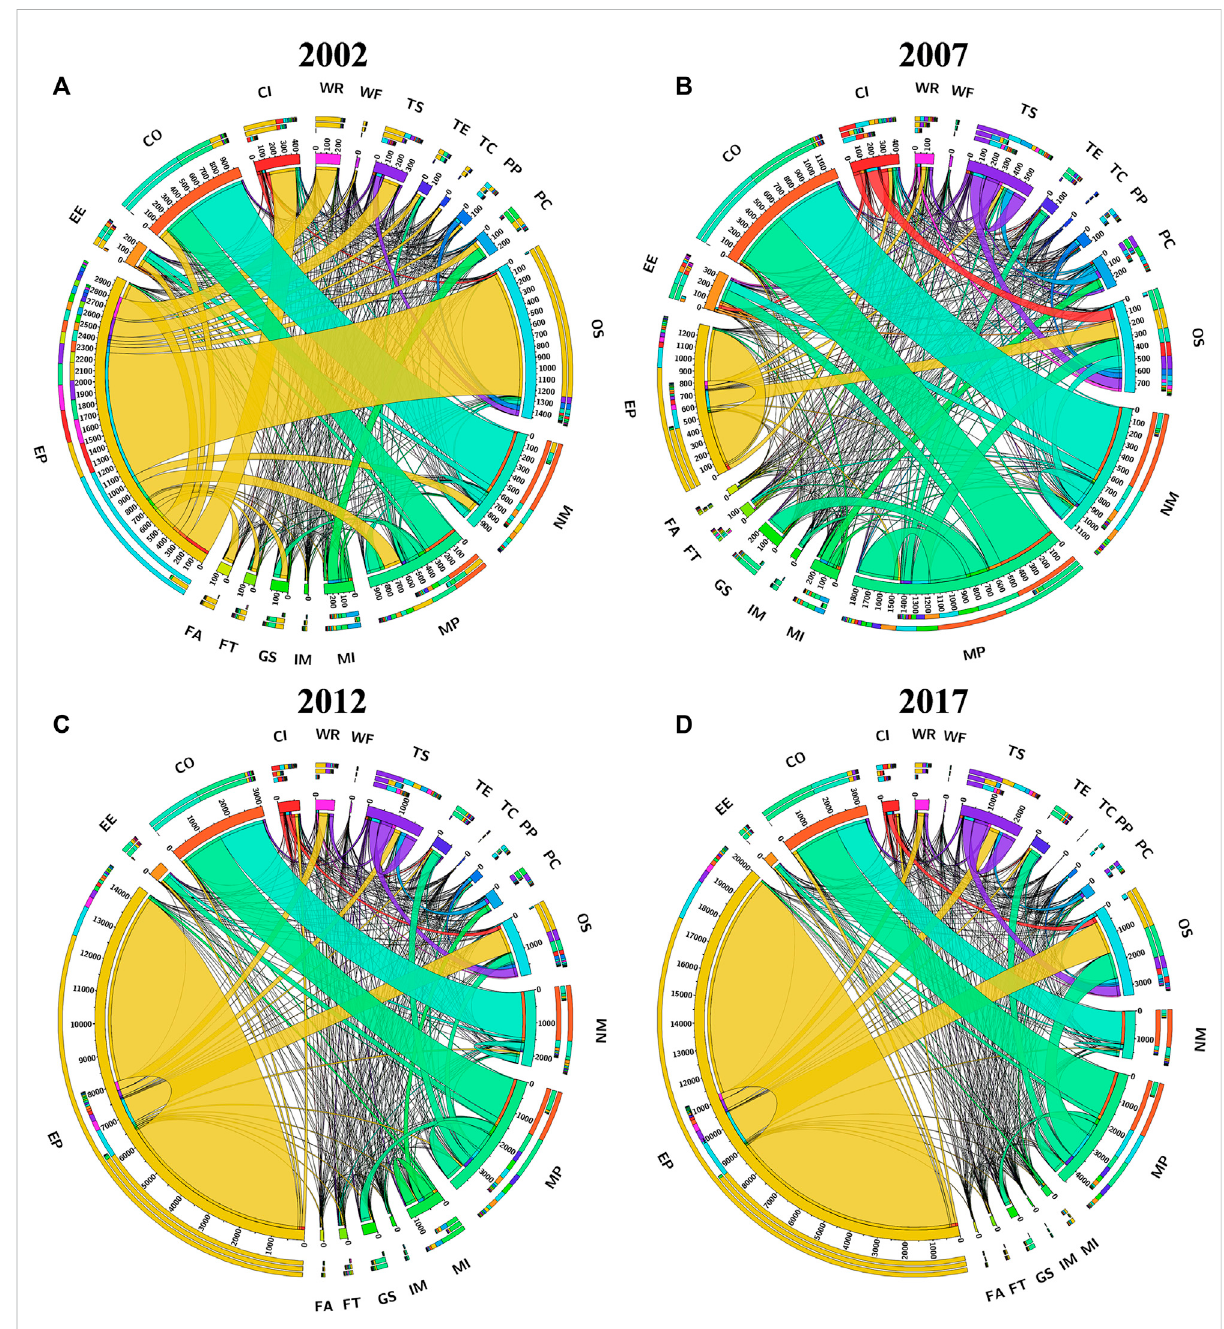
relationship of imported products among sectors was more stable than that of local products. For instance, the imported carbon fl ows from NM and MP to CO persisted between 2002 and 2017, while the relationship in local carbon fl ows disappeared after 2012. It indicated that the local carbon fl ow of CO was more susceptible than its imported carbon fl ow. Changing the